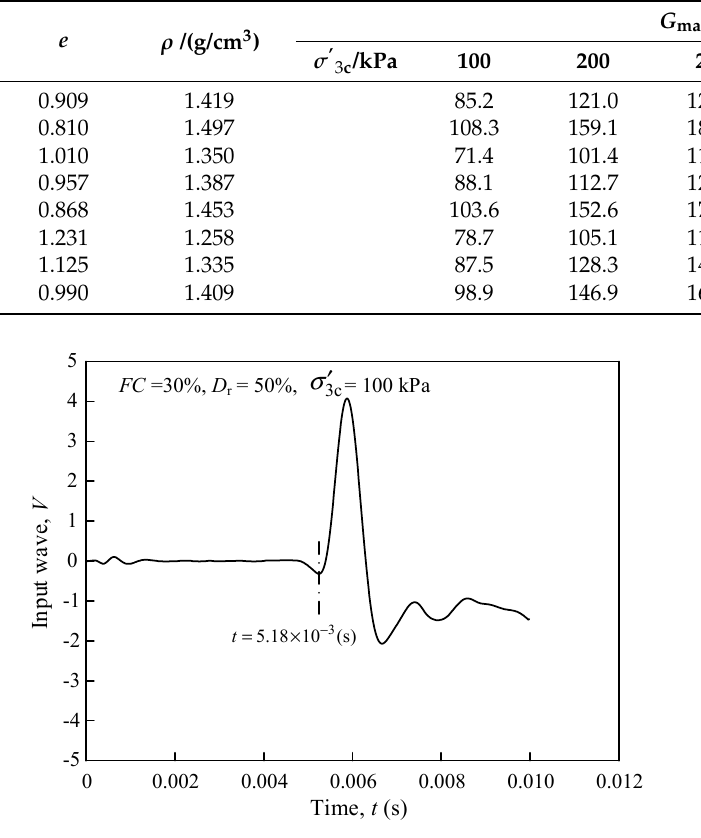
Figure 4. The typical signal wave of the bender element test.